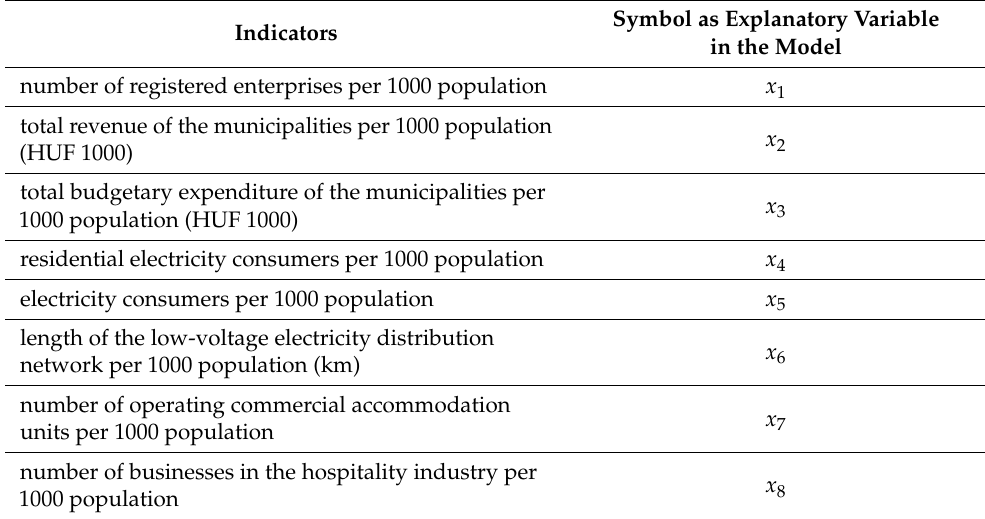
Table 1. Settlement indicators used in the development examinations.